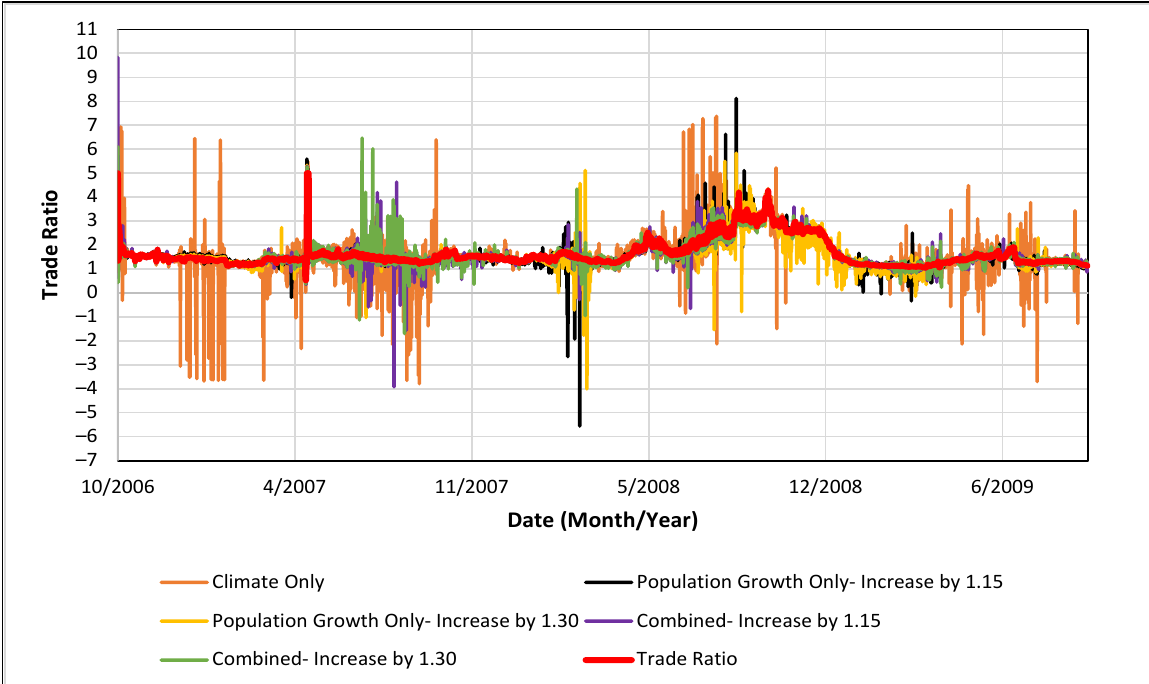
Figure 7. Composite Trade Ratio based on Sums for Delivery + Downstream Components with Equivalency Adjustments for Theoretical WQT Buyer TN Combined with Suggested Margins of Safety for Climate and Population Characteristics over the Jordan River Simulation Period (1 October 2006 to 30 September 2009) for RCP 6.0.